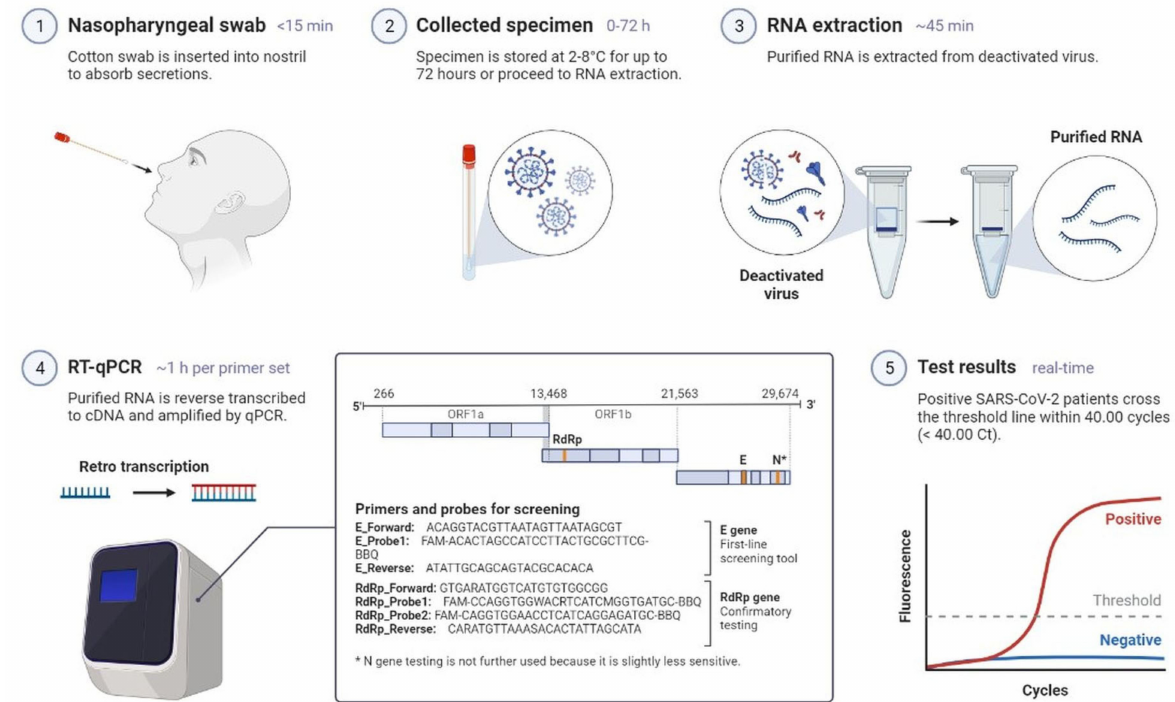
Figure 2. Representation of COVID-19 diagnostic test through RT-PCR.